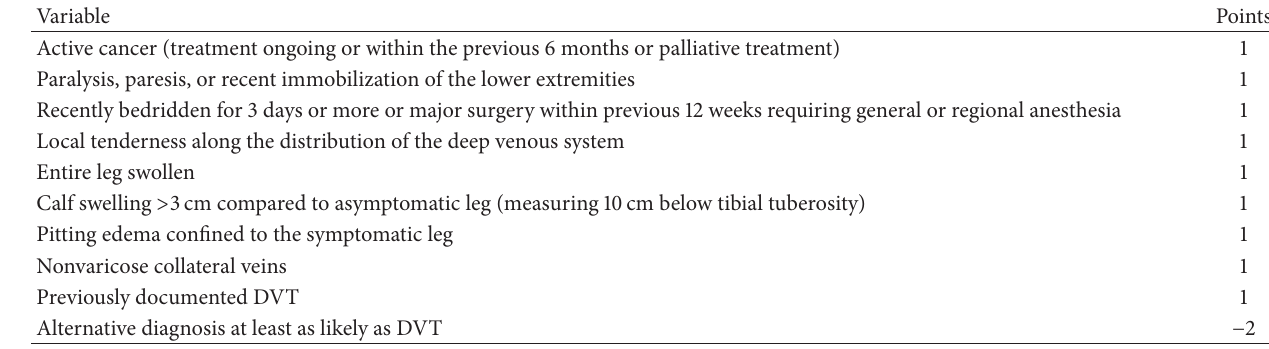
Table 1: Wells score for DVT (adapted from